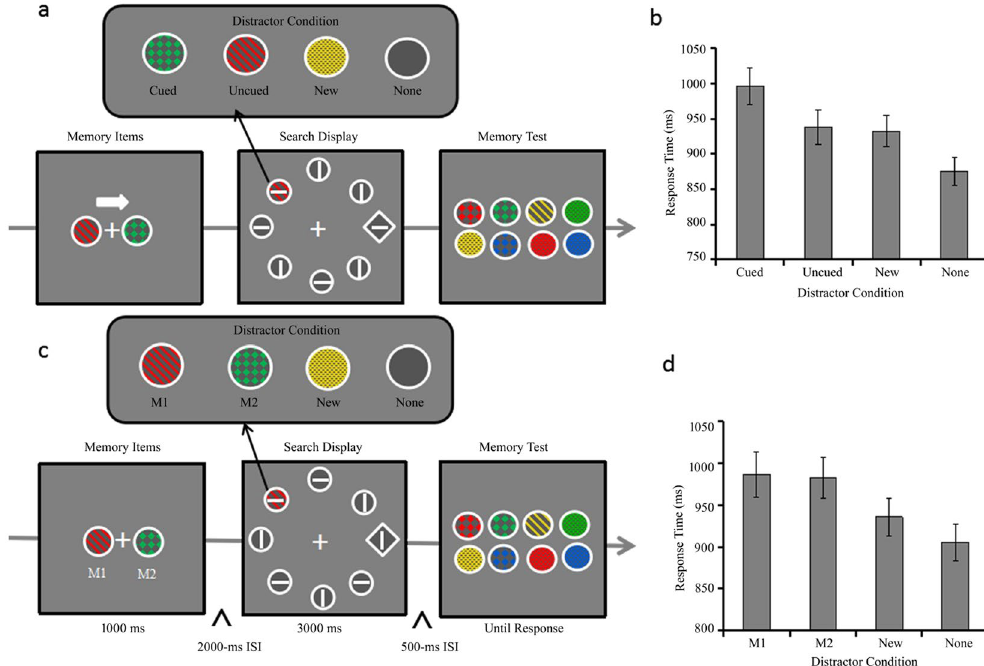
Figure 4. Trial sequences and results for Experiment 4. ( a ) The sequence of events with four possible distractor conditions in a trial for the single cued memory item condition (The Cued, Uncued, New and None distractor condition were the same as those in Exp 2). ( b ) RTs for the search task as a function of distractor condition in the single cued memory item condition. ( c ) The sequence of events with four possible distractor conditions in a trial of the two memory items condition (The M1, M2, New and None distractor condition were the same as those in Exp 2). ( d ) RTs for the search task as a function of distractor condition in the two memory items condition. Error bars indicate ± 1